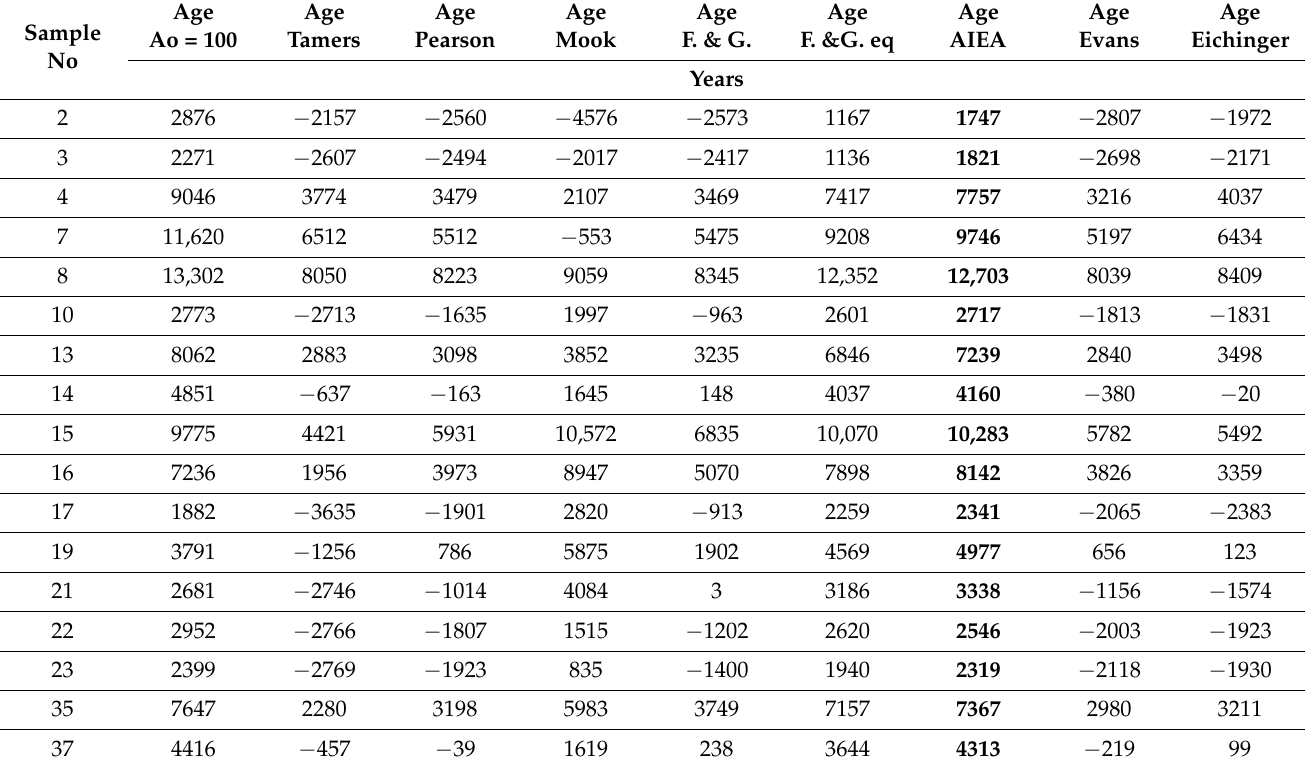
Table 2. Corrected 14 C ages expressed in years with different